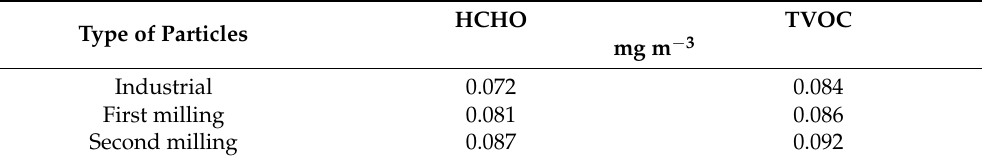
Table 3. The emission of HCHO and TVOC of the tested panels produced using different